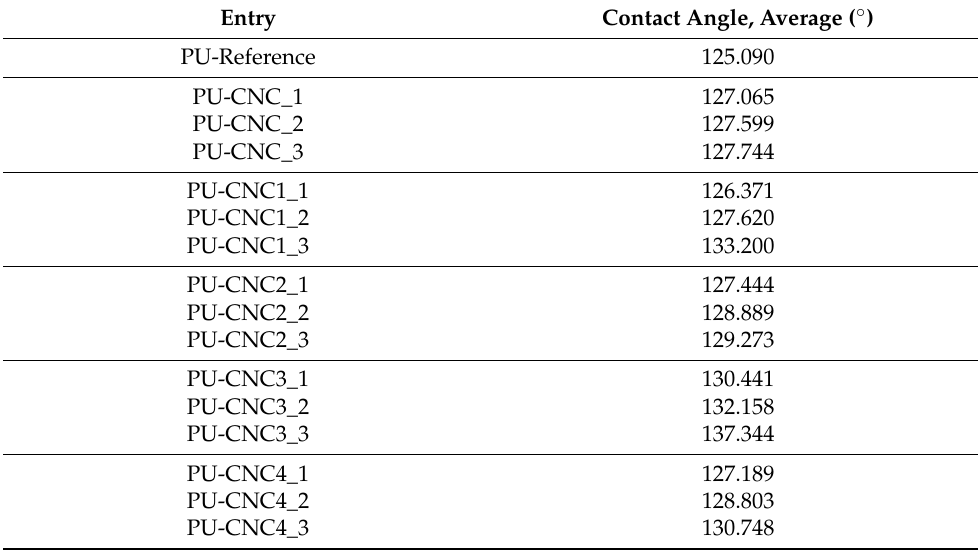
Table 5. Contact angle measurement of reference PU-reference, PU filled with un-modified CNC and modified CNC at different